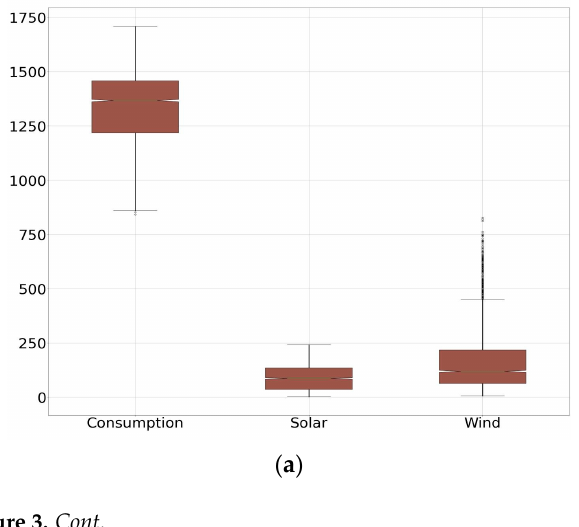
Table 2. Descriptive statistics of the